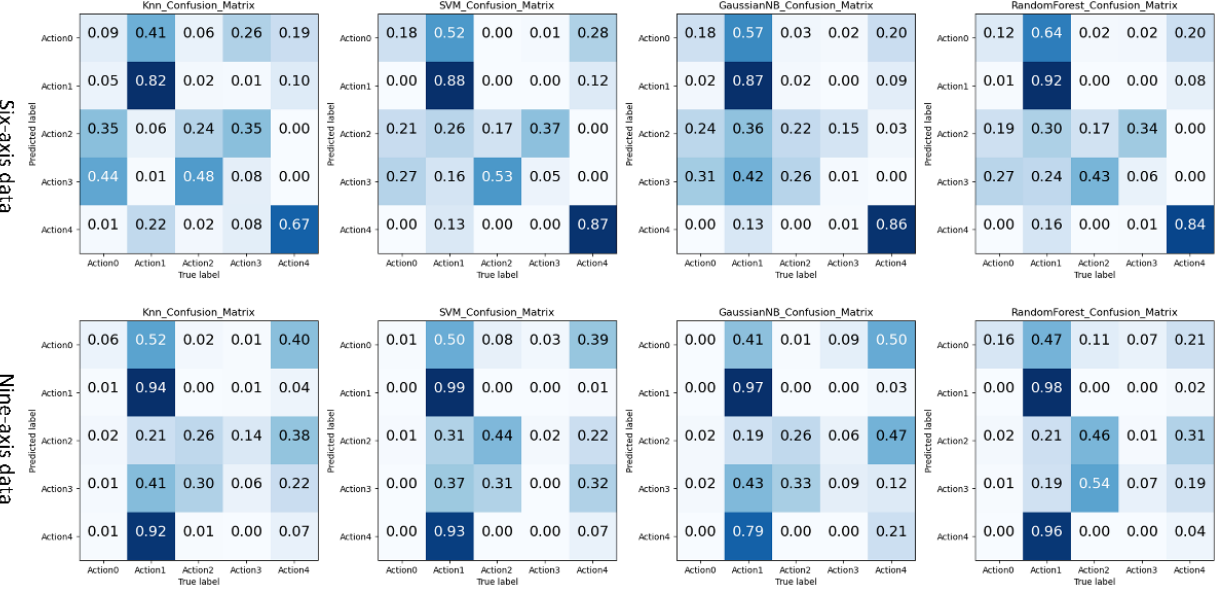
Figure 13. The recognition accuracy of traditional machine learning models based on artificial features on non-professional test sets.